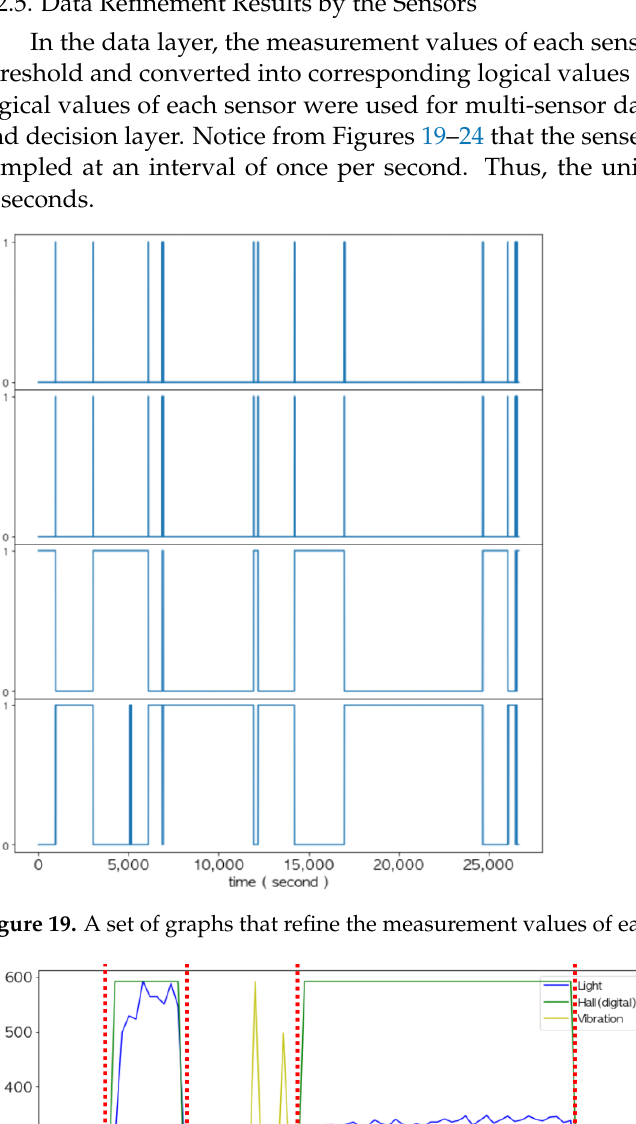
Figure 21. Changes in the sensed values when placing an item in and taking it out from the smart storage.